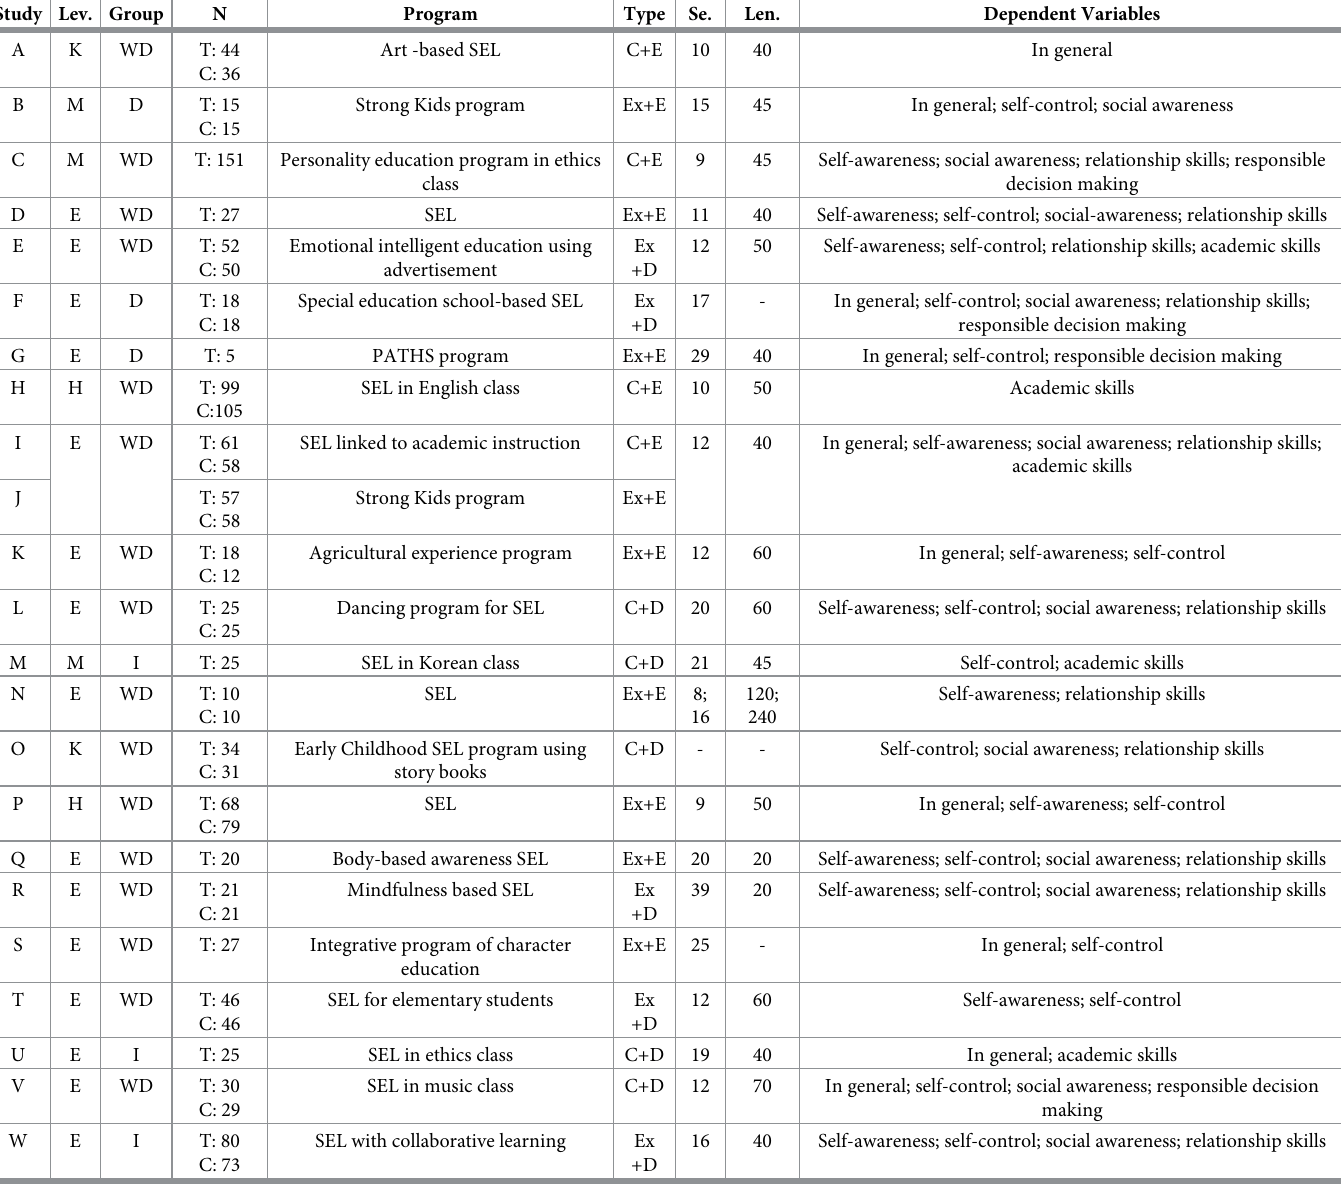
Table 2. Descriptive of study characteristics. Study Lev.